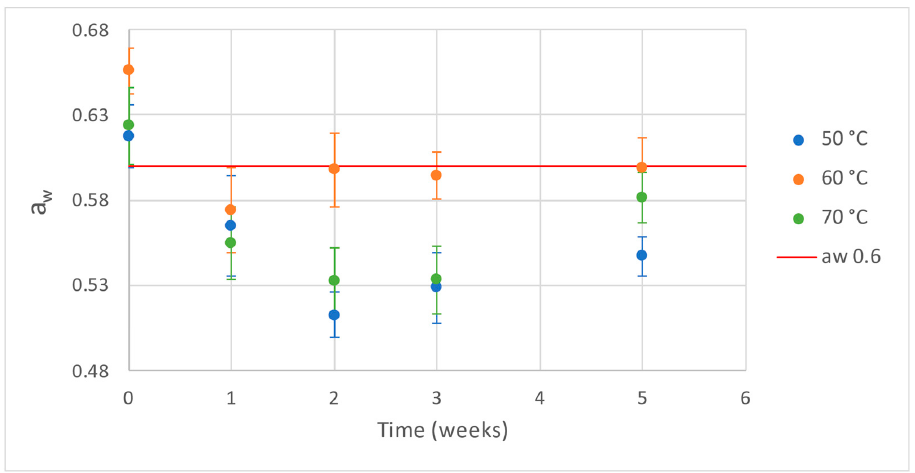
Figure 5 . Average water activity values and confidence intervals for the three drying temperatures. The red line represents a w = 0.6.